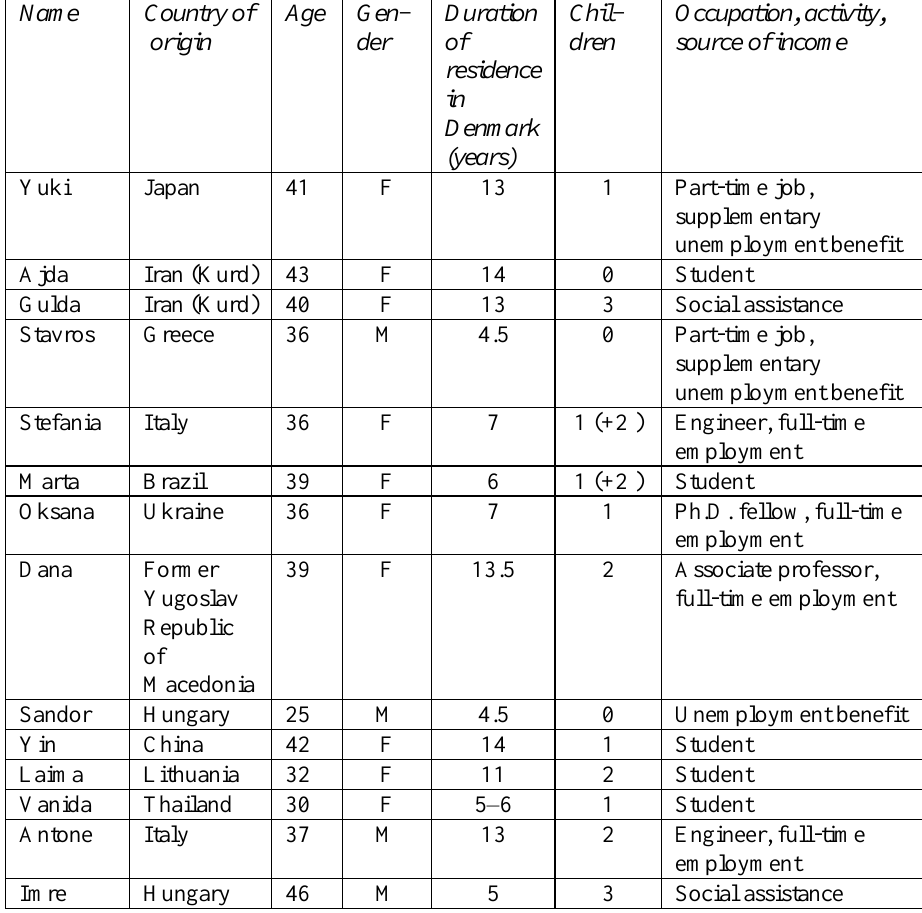
Interviewees’ sociodemographic